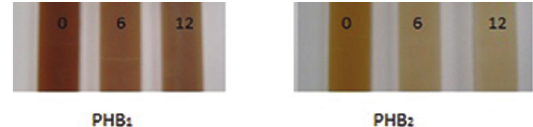
Figure 1: Structural units of 3-hydroxybutyrate HB (a) and 3-hydroxyvalerate HV (b). Type I (ASTM D-638) tensile test specimen of PHB PHB and PHB were produced in a Romi 130 injection 2 ABS